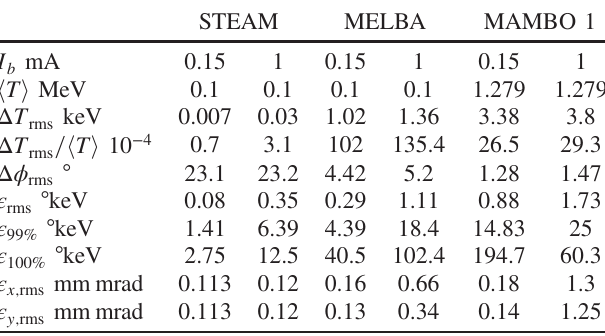
TABLE I. Bunch data of the 100 keV beam as extracted from ¼ 150 μ A and I ¼ 1 mA and at the end of STEAM at I b b MELBA. The phase space distribution of the beam injected into MAMBO is shown in Fig. 2. The acceptable phase spread of the ¼ (cid:2) 80 °. Additionally the transverse rms- chopper was set to Δ ϕ c